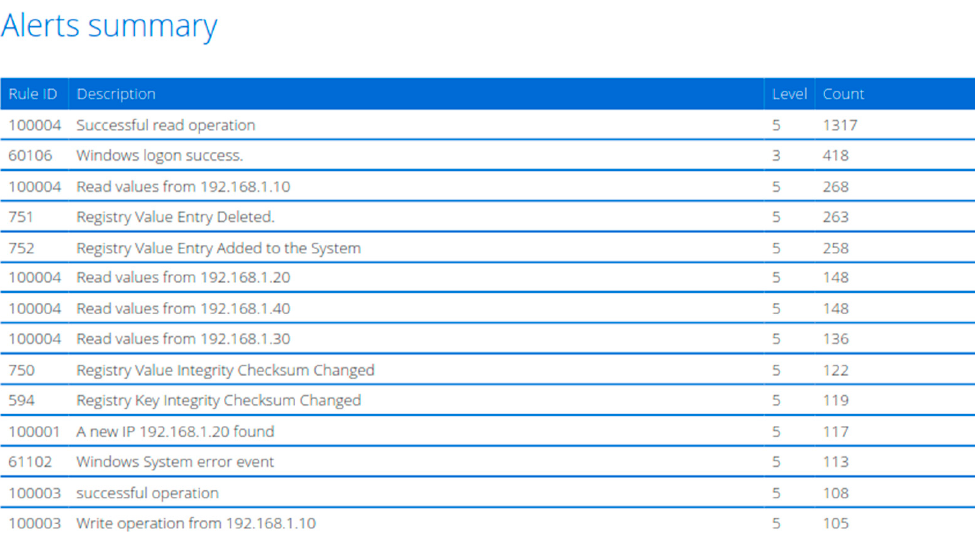
Figure 19. Graphical Representation of Alerts in Wazuh.